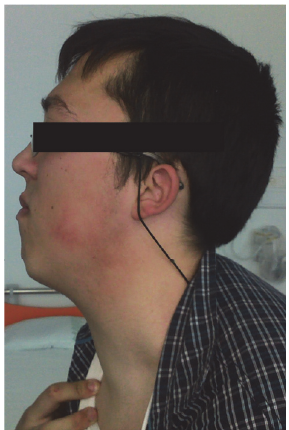
Figure 2: Patient photograph showing diffusely enlarged thyroid gland (left